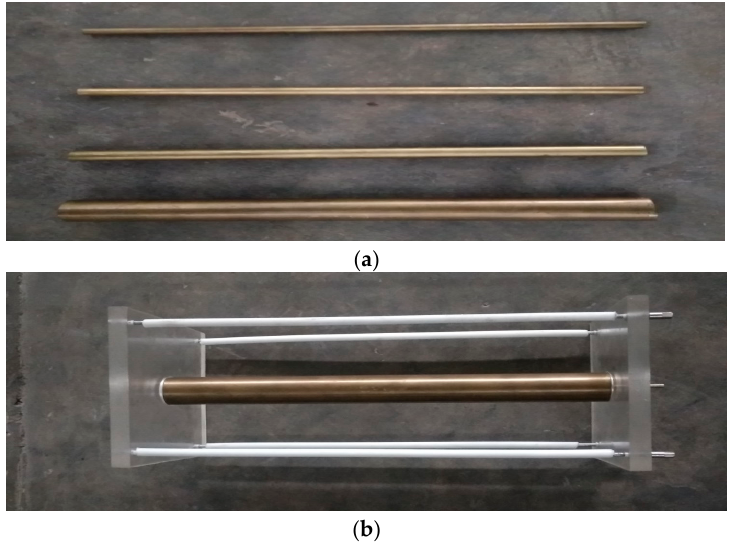
Figure 4. Experimental set-up with electrode configuration to determine the dielectric strength of oils at high voltage. ( a ) Electrodes of different diameter, ( b ) Electrode set-up.